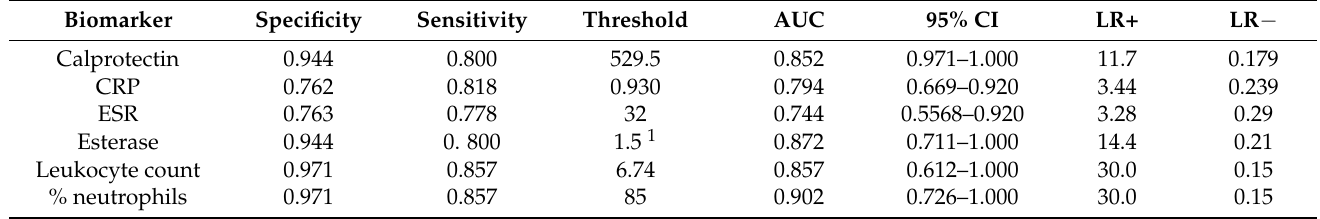
Table 3. Sensitivity, specificity, LR+/ − , test threshold, and the AUC of tested PJI biomarkers.